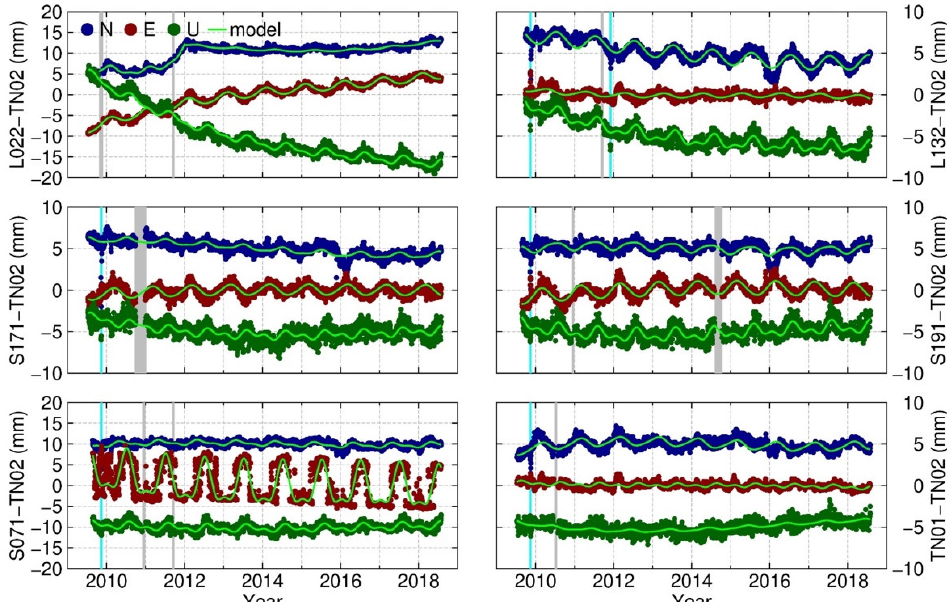
Figure 4. Baseline coordinate time-series and fitting models (North and Up components are moved upward and downward to distinguish the time series. Note the range of the coordinate axes of L022–TN02 and S071–TN02 is larger than that of other baselines). The vertical cyan lines indicate days when there was heavy snowfall and the snow cover changed the antenna phase center, resulting in aberrant solutions in the time series. The gray slices indicate the data gaps. Table 3. Linear trend term (mm/yr) and annual and semiannual signal amplitude estimates (mm).